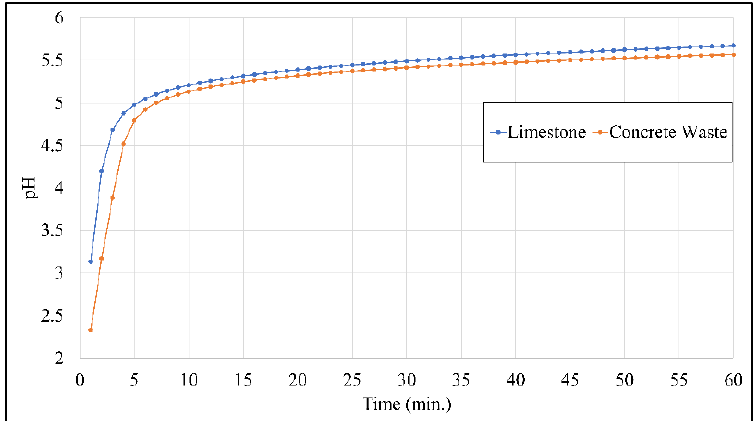
Figure 3. pH plot of limestone and concrete waste.